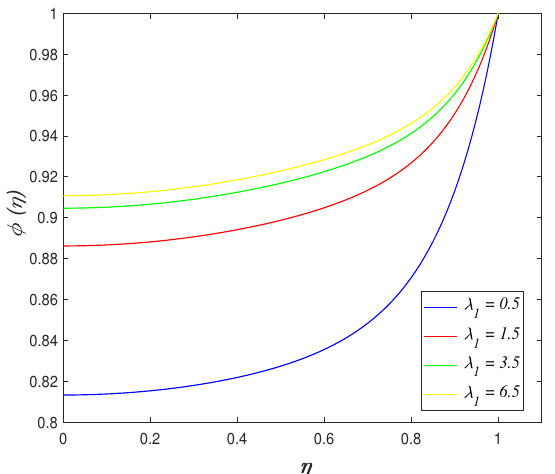
Figure 9. Impact of λ 1 on concentration. The impacts of Ha on velocity, temperature and concentration are displayed in Figures 10–13. The radial velocity slows down with an increase in Ha . The Lorentz force is produced by the induction of a magnetic field in the flow. It raises the resistance towards the flow in the channel. The axial velocity, as shown in Figure 11, decreases for η ≤ 0.5, and it accelerates for η > 0.5 when Ha increases. The crossflow is observed at the center of the boundary layer. The effect of Ha on the temperature field is presented in Figure 12. It is found that the flow temperature reduces for η ≤ 0.9, and it increases for η > 0.9 for a rise of Ha . Figure 13 describes the variation of Ha on nanoparticle concentration. The concentration profile rises on η ≤ 0.85, and it drops on η > 0.85 with a rise in Ha.